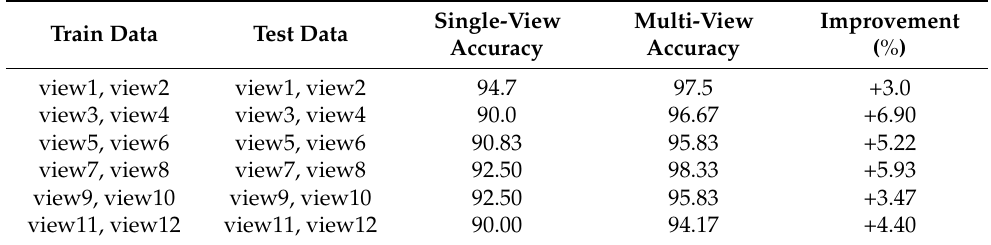
Table 6. State-of-the-art model [50] accuracy of single-view and multi-view learning on KTH-TIPS2. Train